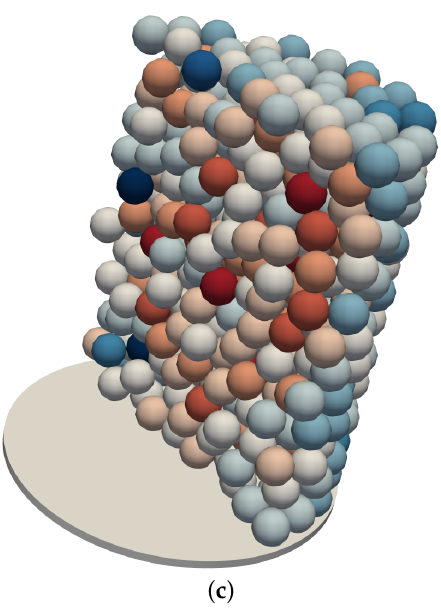
Figure 4. Packing coordination number. ( a ) statistical distribution; ( b ) packing within virtual container with cutoff of two particle diameters from cylindrical boundary; ( c ) diametric section of the same